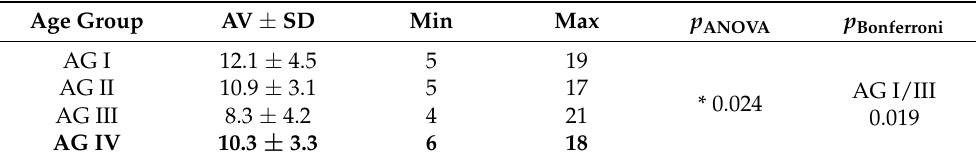
Table 2. GHQ total score in each age group (AV ± SD = average and standard deviation, mini- mum/maximum value).